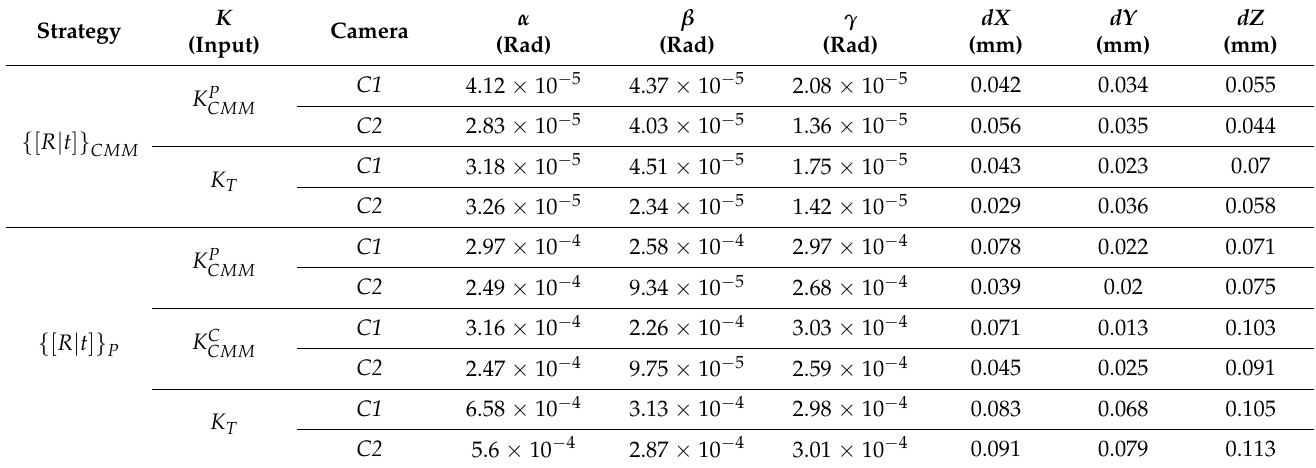
Table 3. The precision results for the extrinsic calibration procedure, considering the combination of different strategies from intrinsic and extrinsic parameters for both